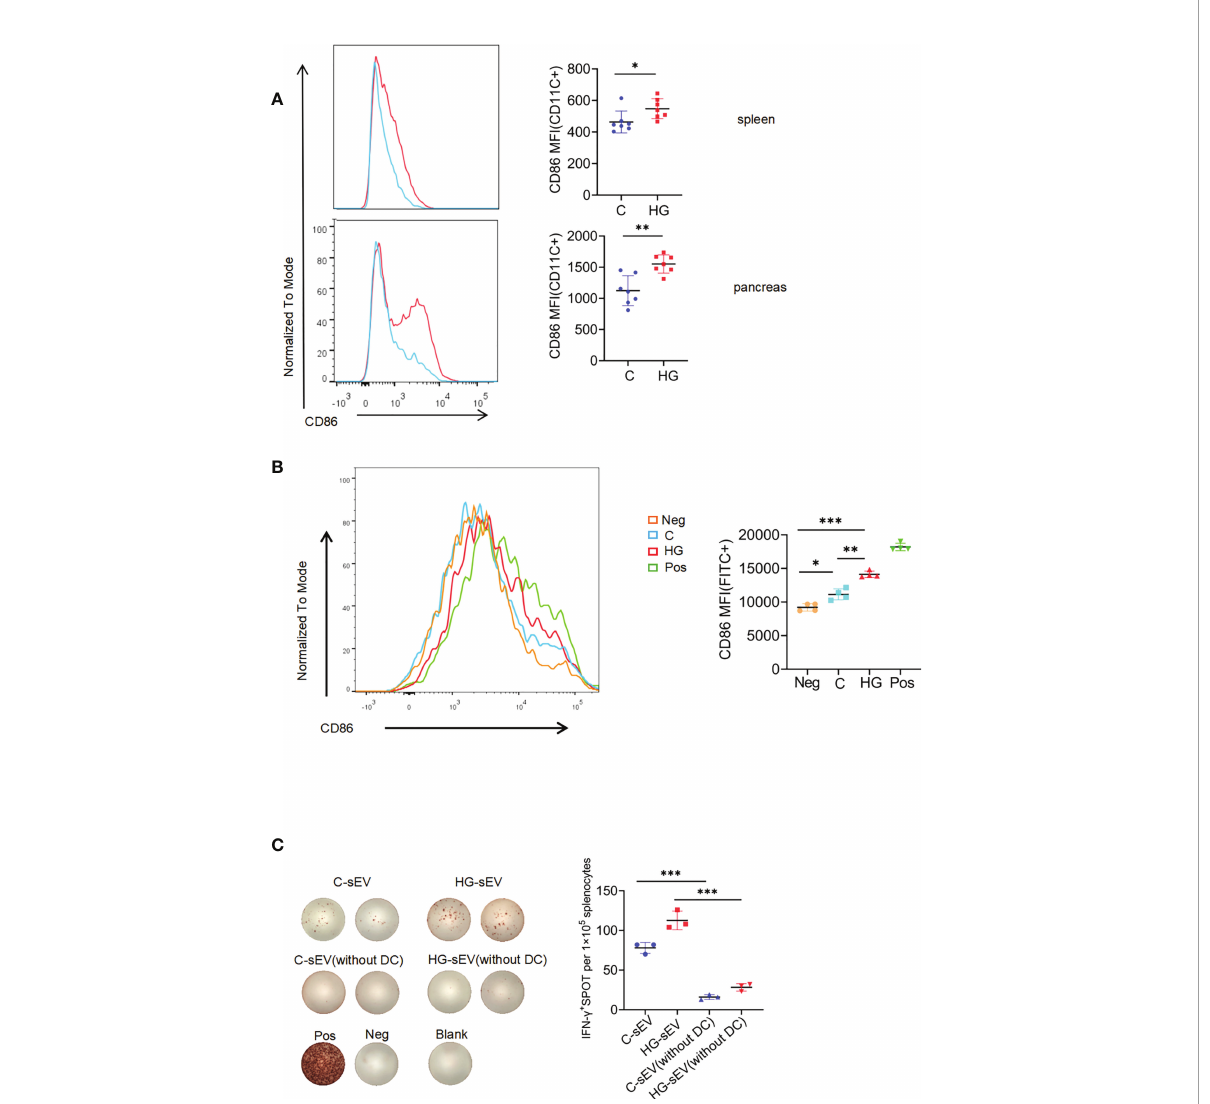
FIGURE 5 sEVs communicate with immune system via dendritic cells (A) The expression of costimulatory molecule CD86 on CD11c + subset in spleen and pancreatic in fi ltrating cells of NOD mice given normal water (C) and high-glucose water (HG) (n=7). (B) The expression of CD86 on bone marrow-derived dendritic cells alone (Neg), or co-cultured with sEVs released from untreated (C) , or high-glucose treated NIT-1 cells (HG), or LPS (Pos). (C) Representative plots of IFN- g production by NOD mouse splenocytes (with or without dendritic cells) alone (Neg), or incubated with untreated NIT-1 cells-derived sEVs (C-sEV) or high-glucose treated NIT-1 cells-derived sEVs (HG-sEV), or PMA plus ionomycin (Pos). Summary data are presented as mean ± SD for one representative result of two independent experiments. *p < 0.05, **p < 0.01, and ***p < 0.001, unpaired two-tailed Student ’ s t